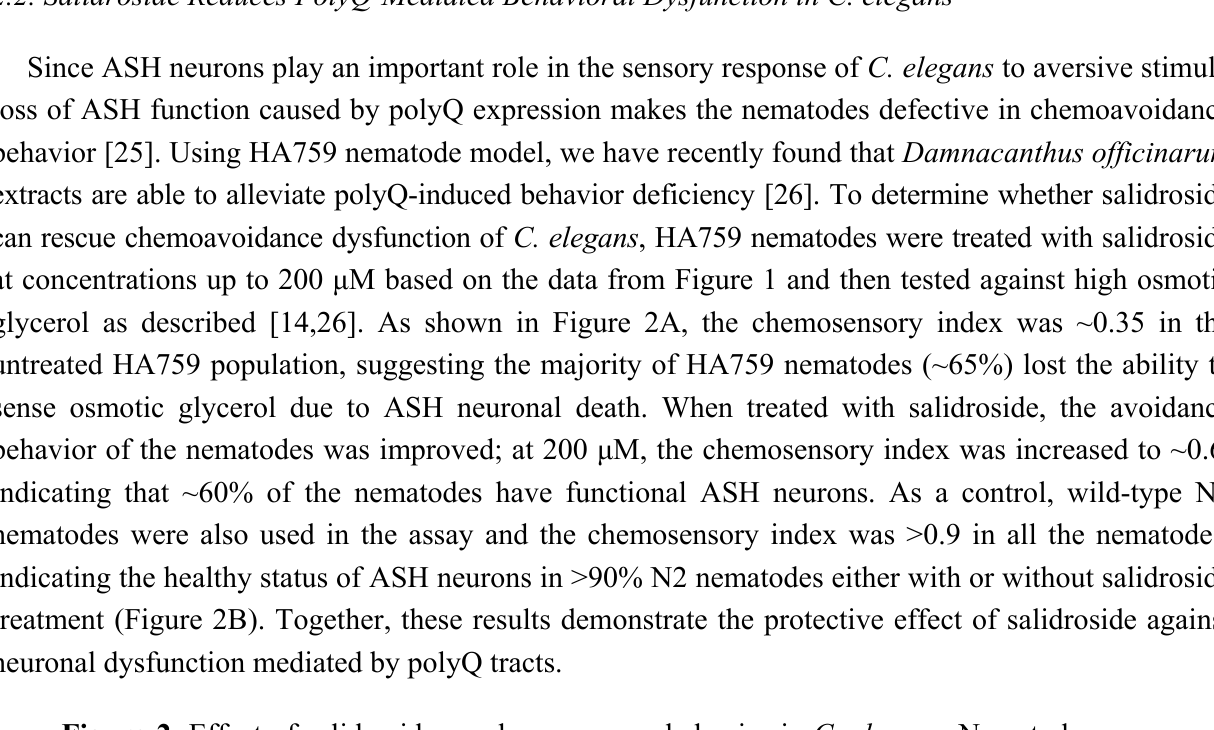
Figure 2. Effect of salidroside on chemosensory behavior in C. elegans . Nematodes were treated with salidroside from L1 at indicated concentrations at 20 °C for 72 h and then subjected to chemosensory assay. ( A ) HA759 nematodes. Data are presented as mean ± SEM of three independent experiments. * p < 0.05; ( B ) N2 nematodes. Data are representative of three independent experiments and presented as mean ±